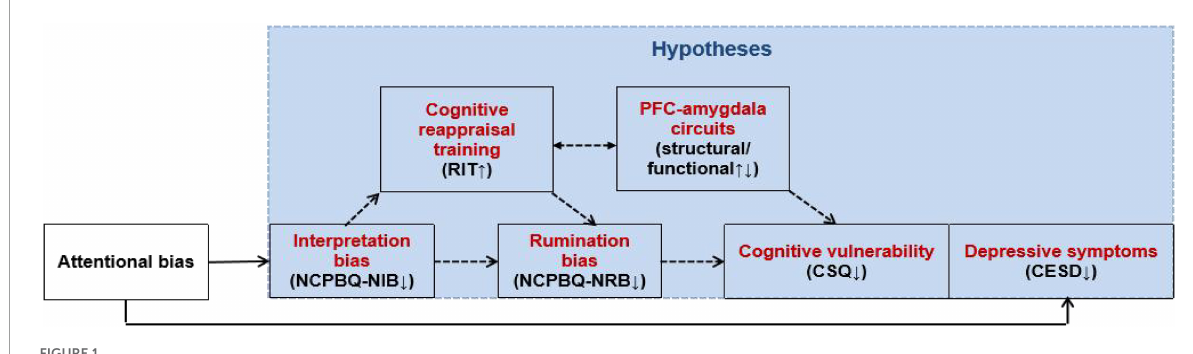
FIGURE1 Antidepressant mechanism of CR training on individuals cognitively vulnerable to depression.